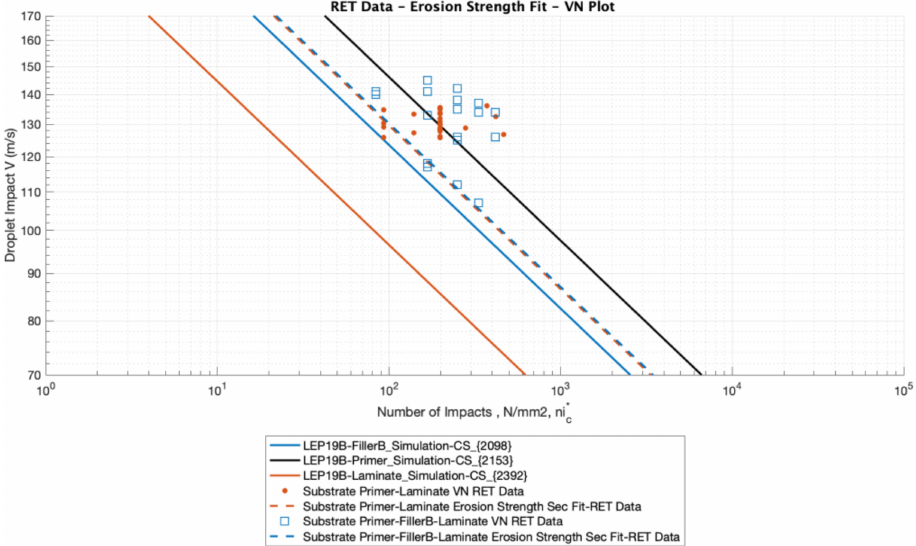
Figure 22. V-N plot for RET testing and simulated coating LEP prototype comparing both the e ff ect of the droplet impact velocity variations though the RET coupon from the root to the tip according DNVGL-RP-0171 and comparing the simulated results when varying the substrate impedance.